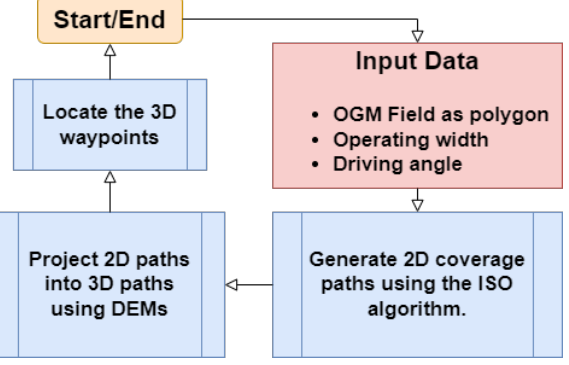
Figure 3. The 3D local goals extraction